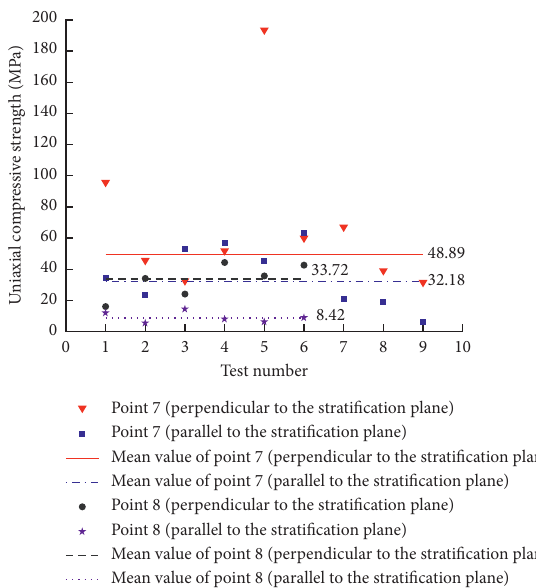
Figure 10: Mineral composition map of rock samples.